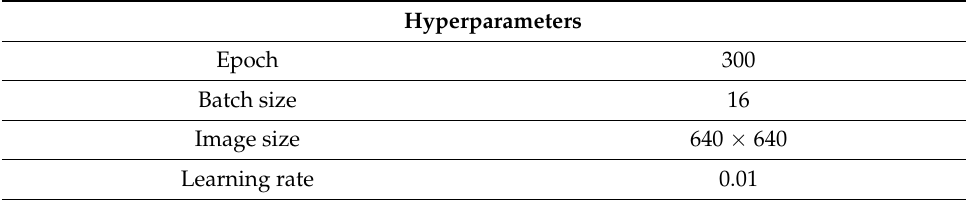
Table 2. Model learning environment (hyperparameters).